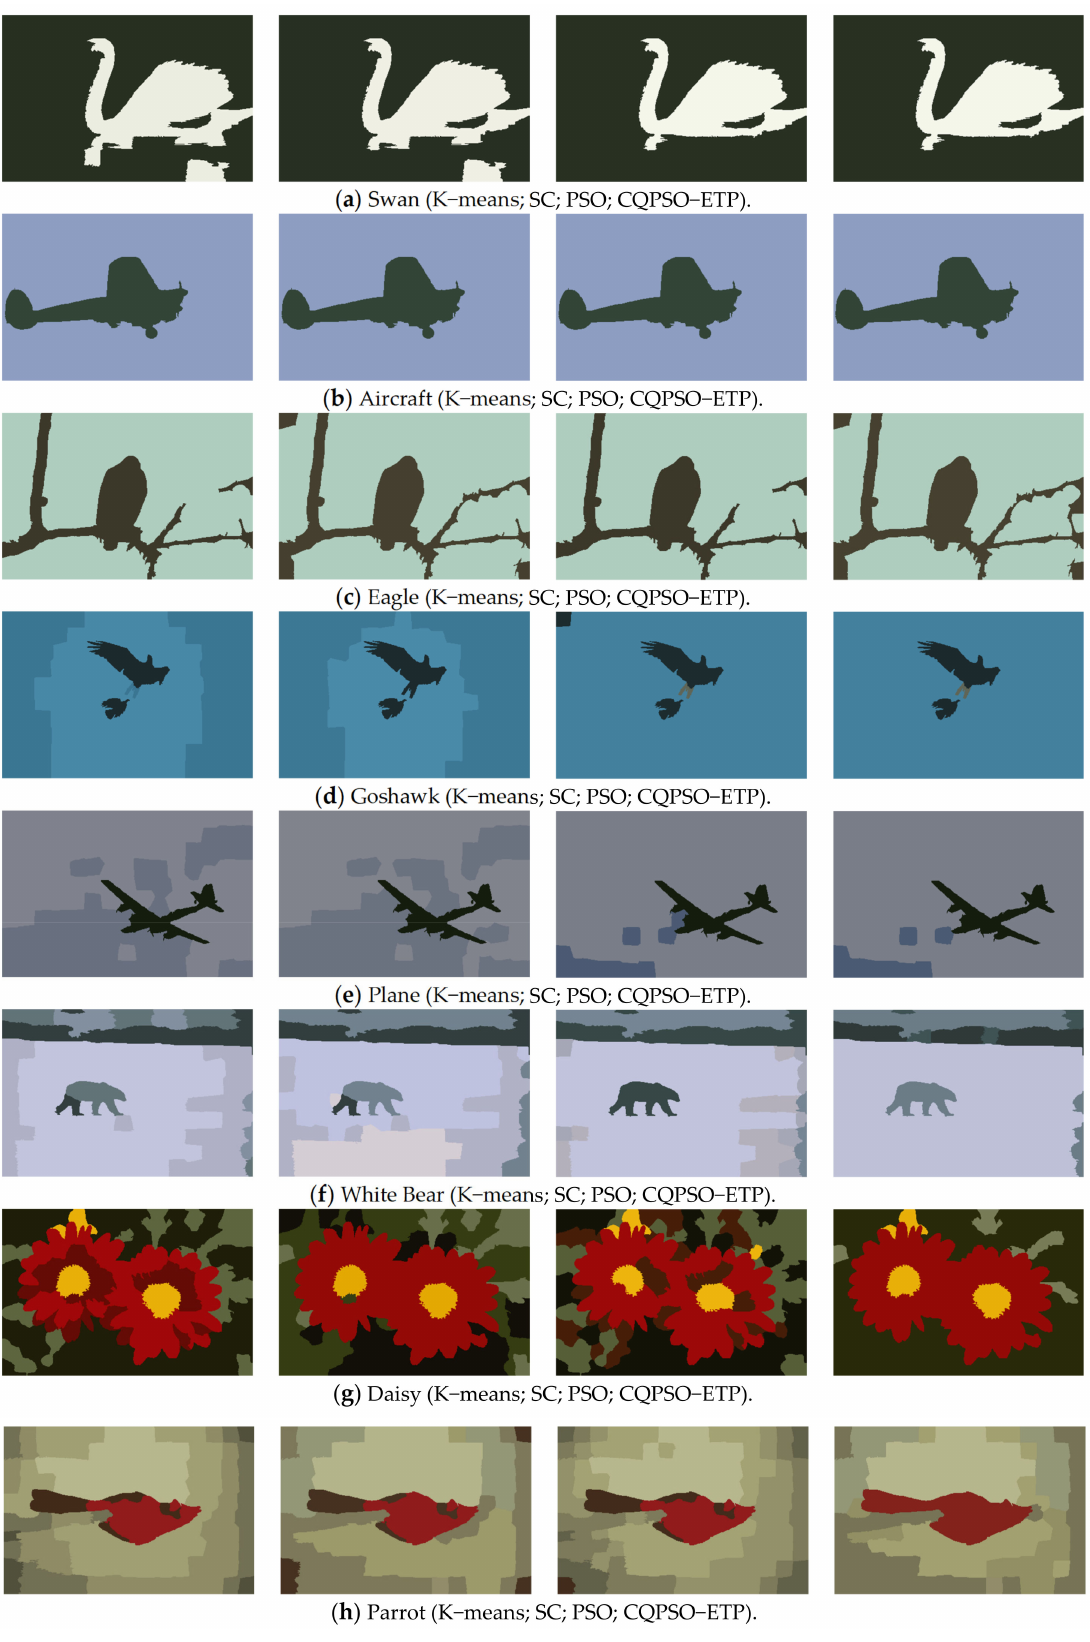
Figure 10. Segmentation results of the comparative clustering approaches on eight tested